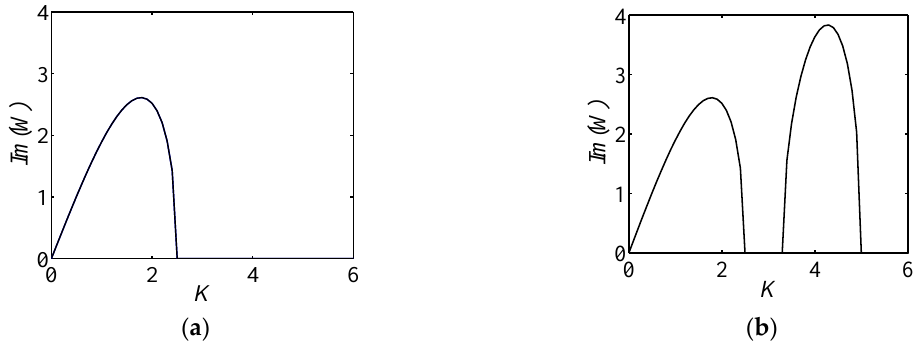
Figure 2. Multiple bands of the modulation instability gain spectra with σ = 10, ρ = 1 and δ = 5: ( a ) the first band; ( b ) the second band.